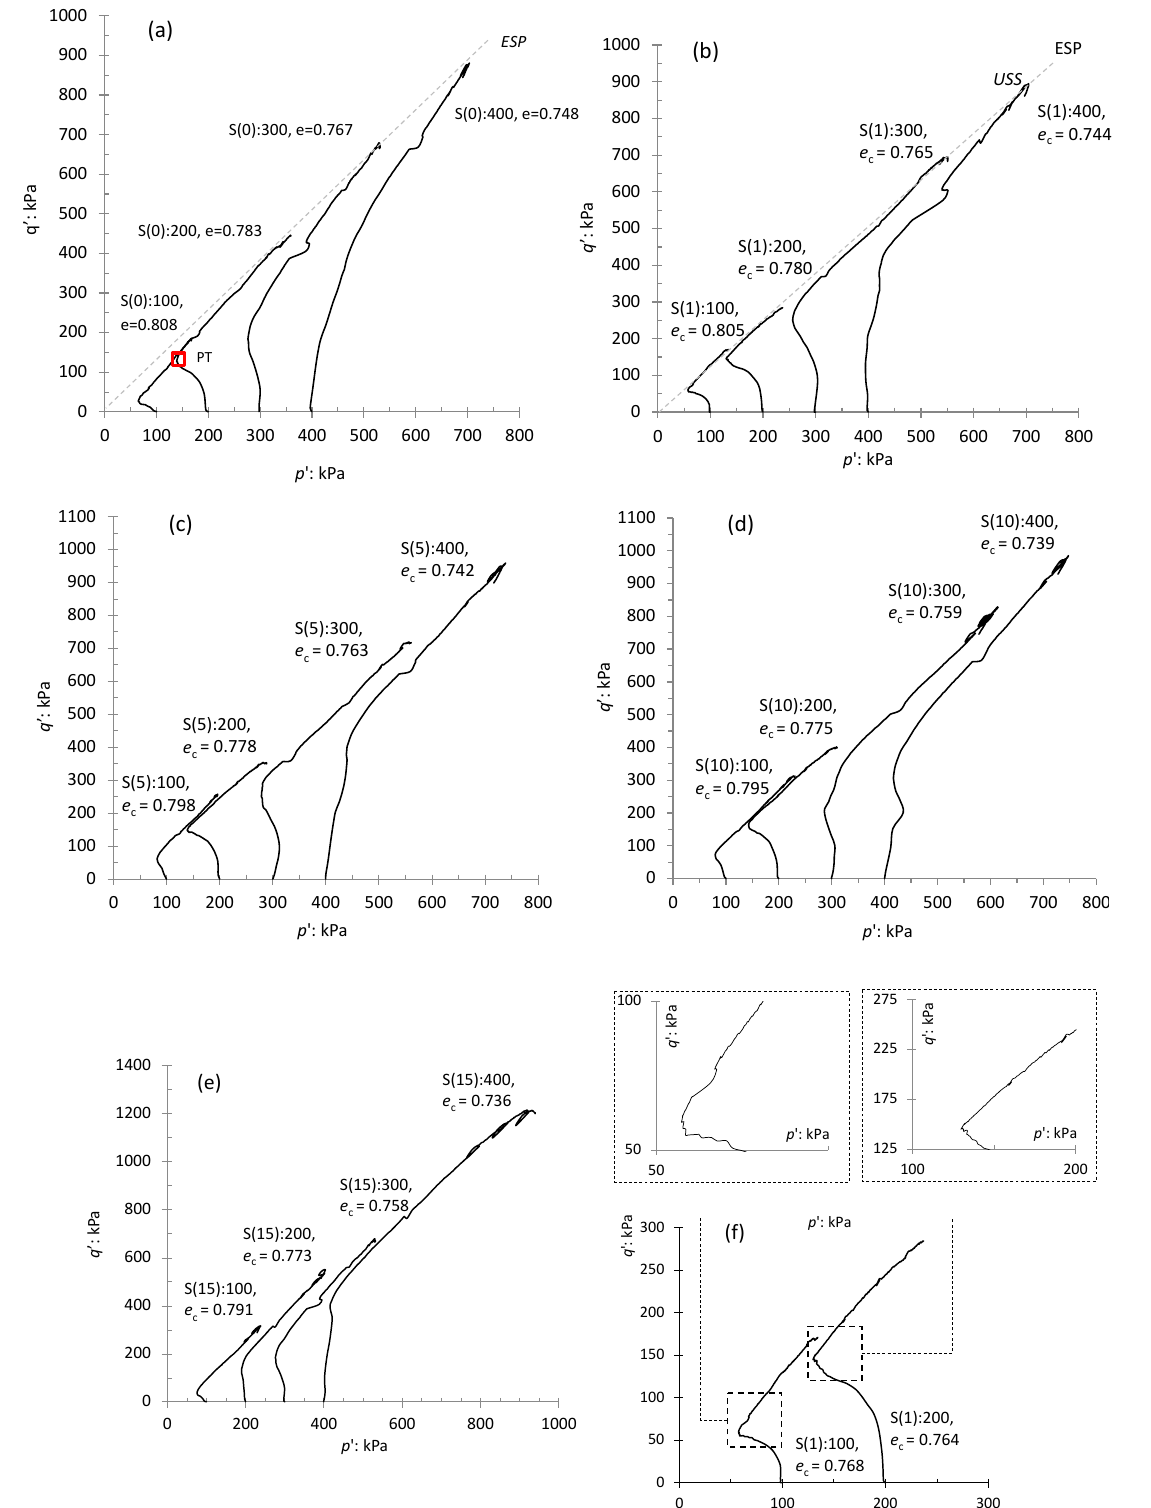
Figure 6 shows the shear responses in the (cid:1869)′ − (cid:1868)′ plane of the base sand and four NS-treated sand mixtures. Stress paths are plotted for four initial mean effective stresses ( (cid:1868)′ (cid:3030) = 100–400 kPa), with the post-consolidation void ratio ( e c ) adopted as the basis for comparison.